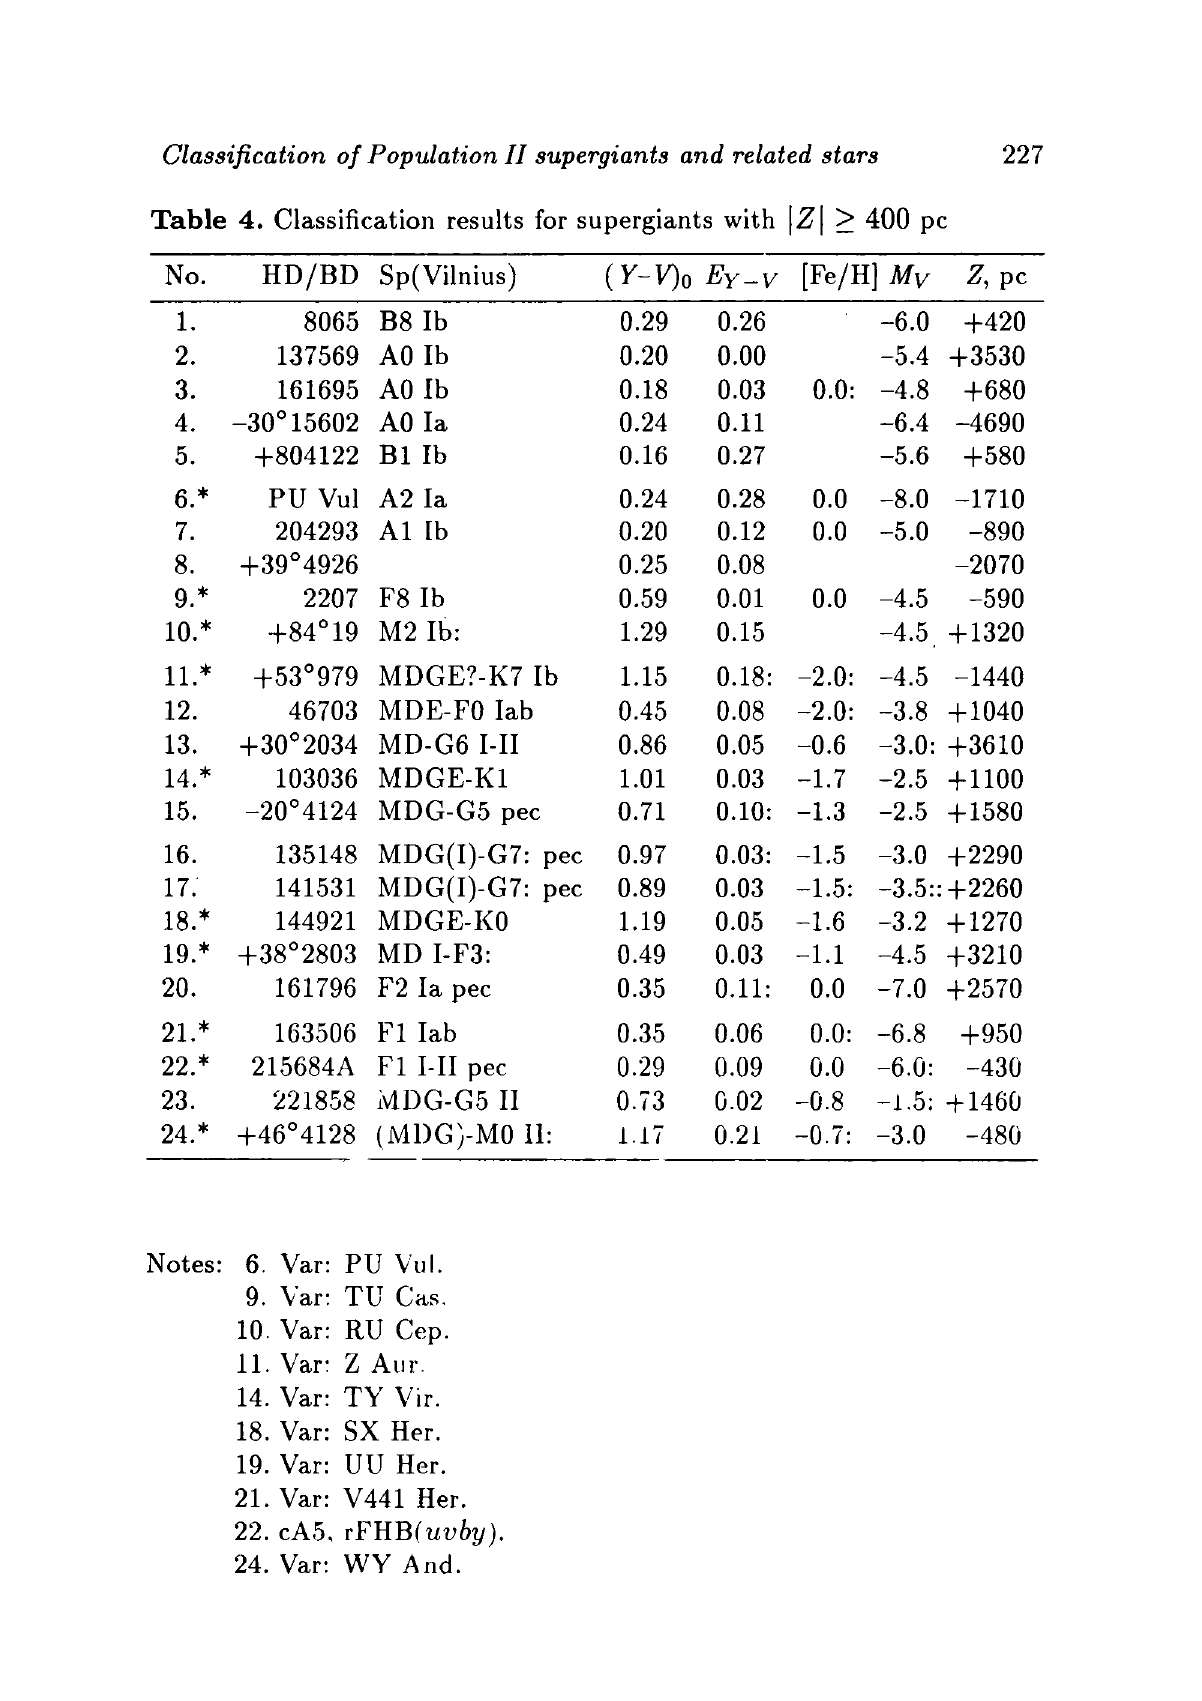
Table 4. Classification results for supergiants with